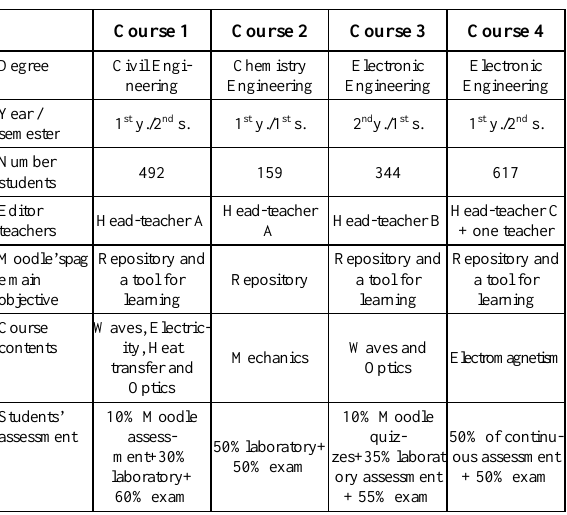
TABLE I. C ASE S TUDIES I DENTIFICATION